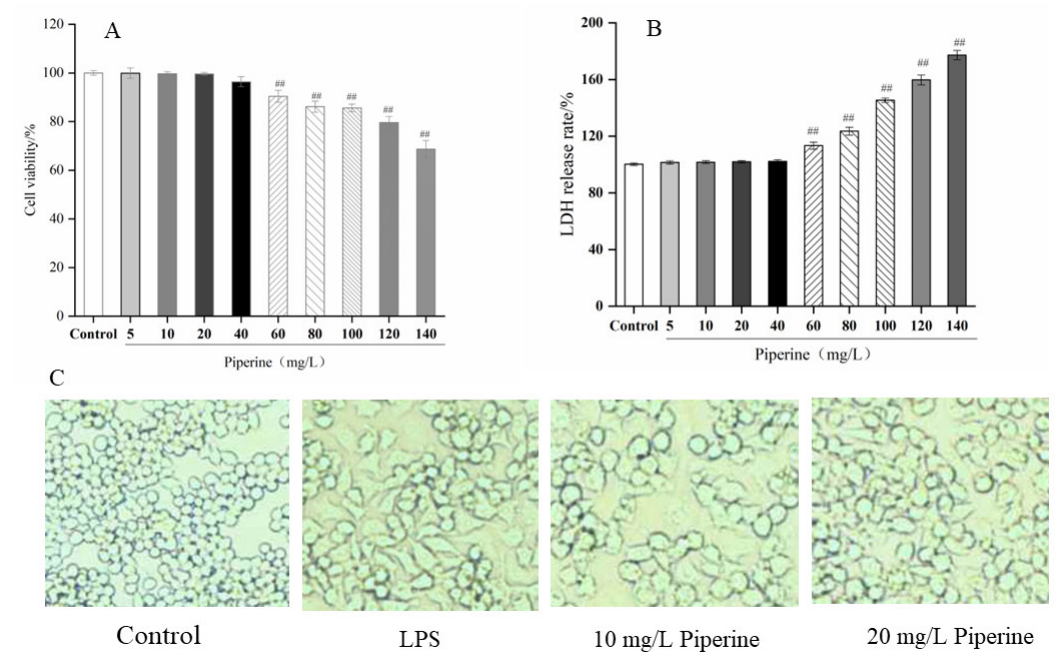
Figure 2. Cell viability ( A ) , LDH release rate ( B ) and morphology analysis ( C ) of piperine in LPS- stimulated RAW264.7 cells. Ave ± SD, ## p < 0.01 vs. control group.